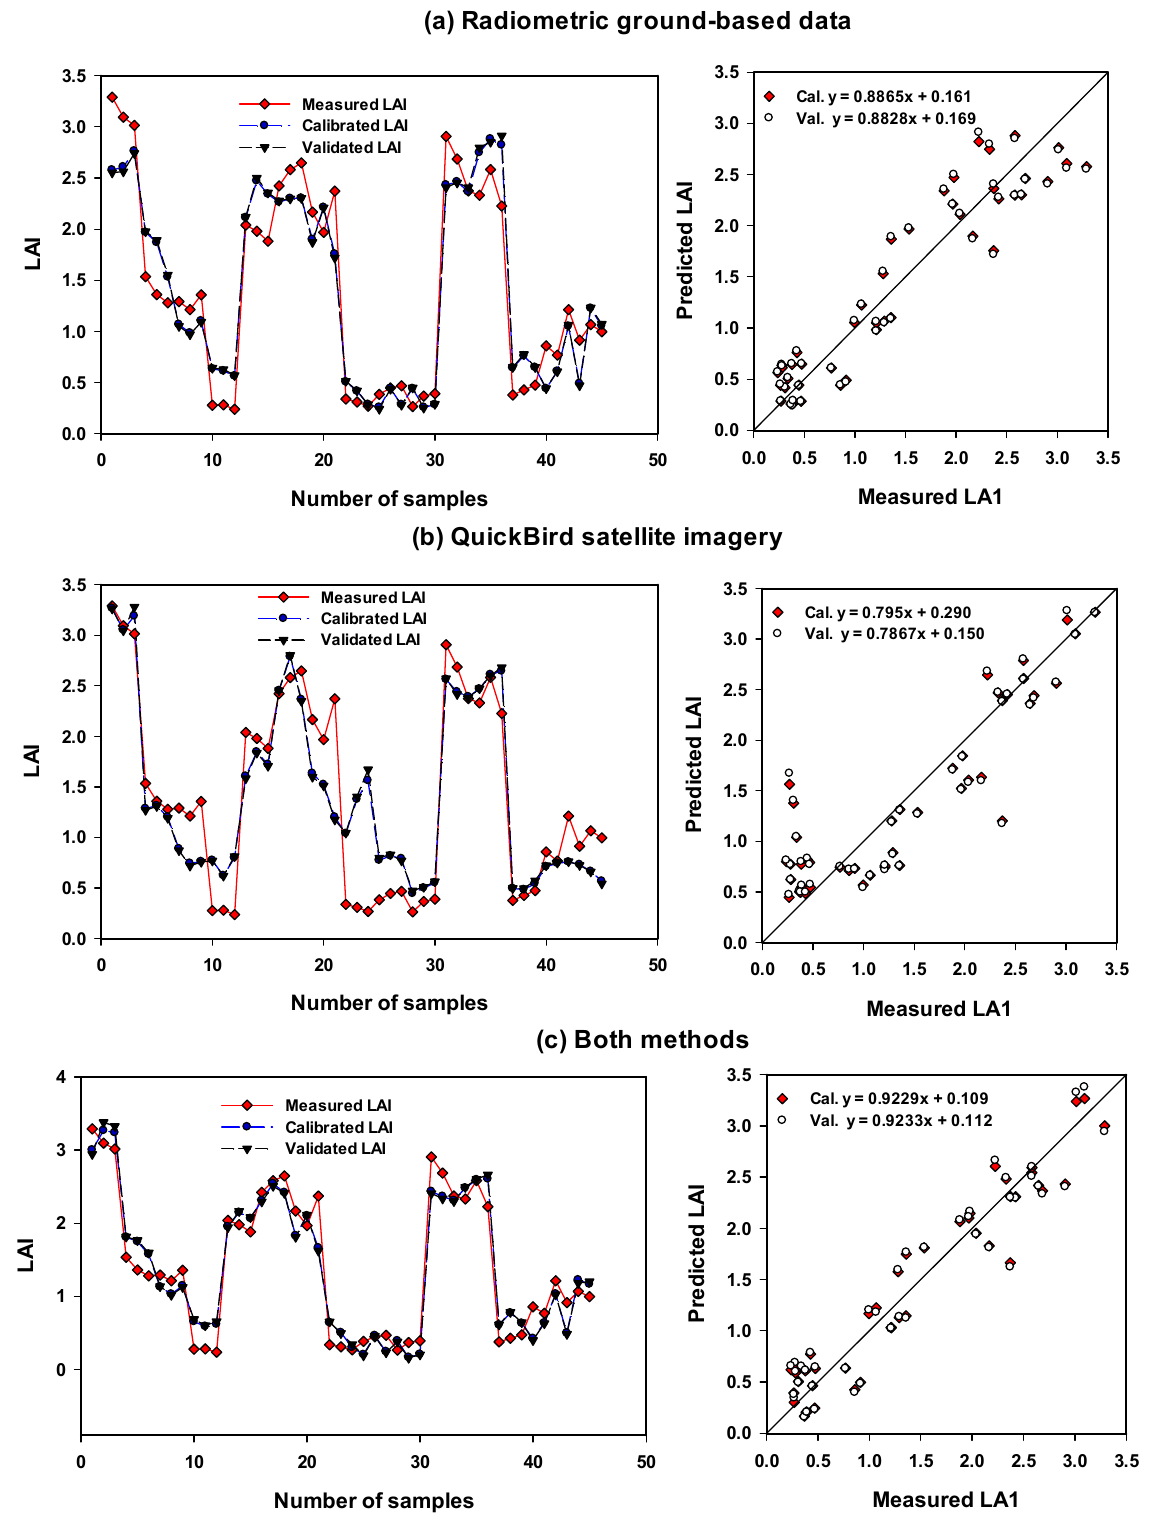
Figure 3. Comparison between measuring series, calibrating series and validating series for leaf area index (LAI) of maize using the PLSR models based on selected vegetation-(SRIs) extracted from ( a ) radiometric ground-based data, ( b ) extracted from QuickBird satellite imagery and, (c) extracted from both methods.